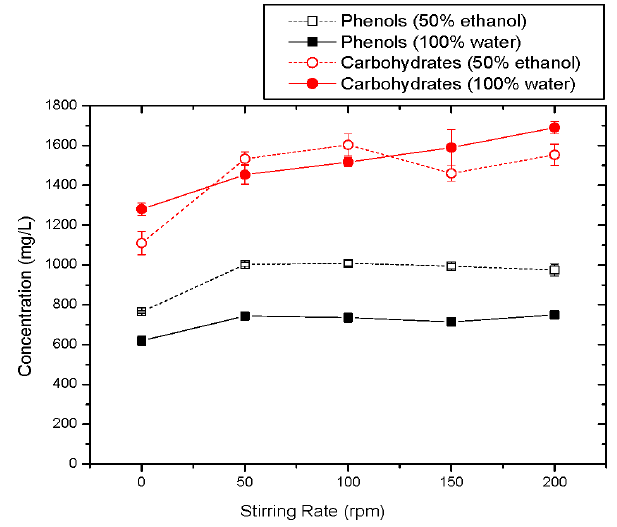
Figure 7. TPC and carbohydrates concentration values versus stirring rate.